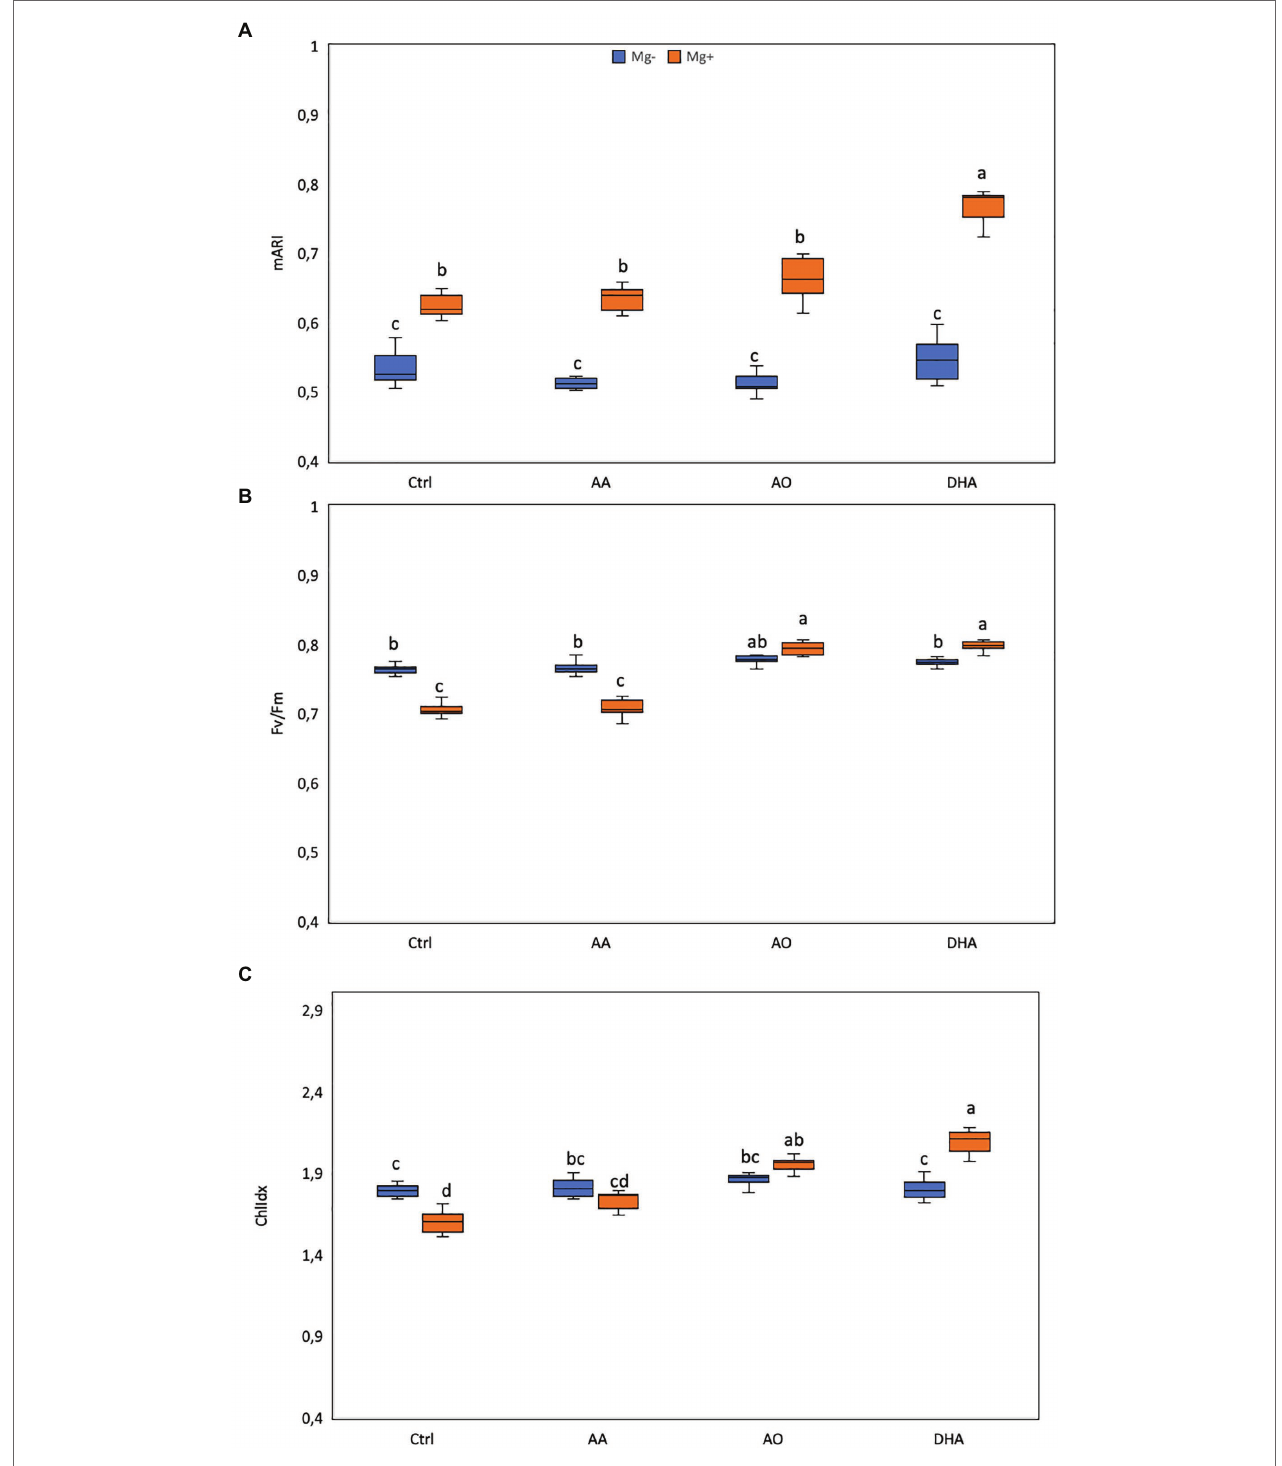
FIGURE 2 | Improved growth and reduced nematode infection in AO/DHA-sprayed plants is correlated with increases in shoot Fv mARI, Fv/Fm, and ChlIdx. The effect of AA (20 mm), AO (20 U/ml), and DHA (20 mm) on (A) modified anthocyanin reflectance index (mARI), (B) Fv/Fm, and (C) ChlIdx in rice leaves. Fourteen-day- old wild-type Nipponbare rice plants were sprayed with 20 mm of AA, 20 ml/unit of AO, and 20 mm of DHA or mock sprayed (Ctrl). After 24 h, plants from each treatment were inoculated with ≈ 250 s-stage juveniles of M. graminicola per plant. Shoots of un/infected plants were monitored for their mARI, Fv/Fm, and ChlIdx values using an automated phenotyping platform (APP) at 3dai ( n = 5). One-way ANOVA was applied for the statistical analysis (Tukey test, α = 0.05), and data are shown by box plots with median. Different letters indicate significant differences among the